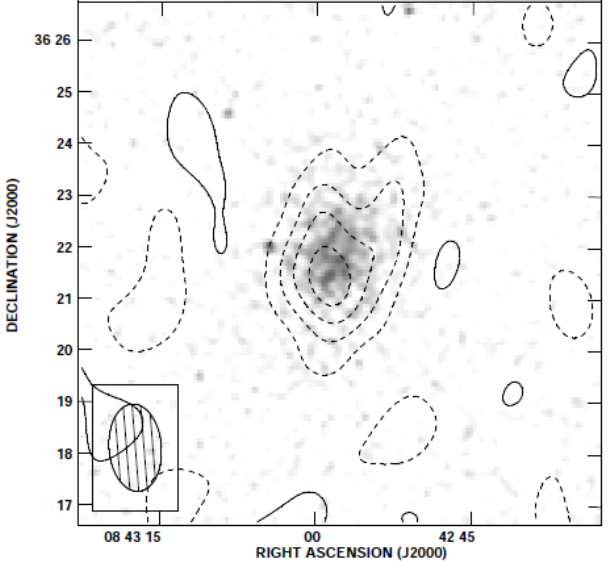
Figure 6: S-Z decrement observation of Abell 697 with the Ryle telescope in contours superimposed on the ROSAT image (grey-scale). Image reproduced with permission from [104]; copyright by